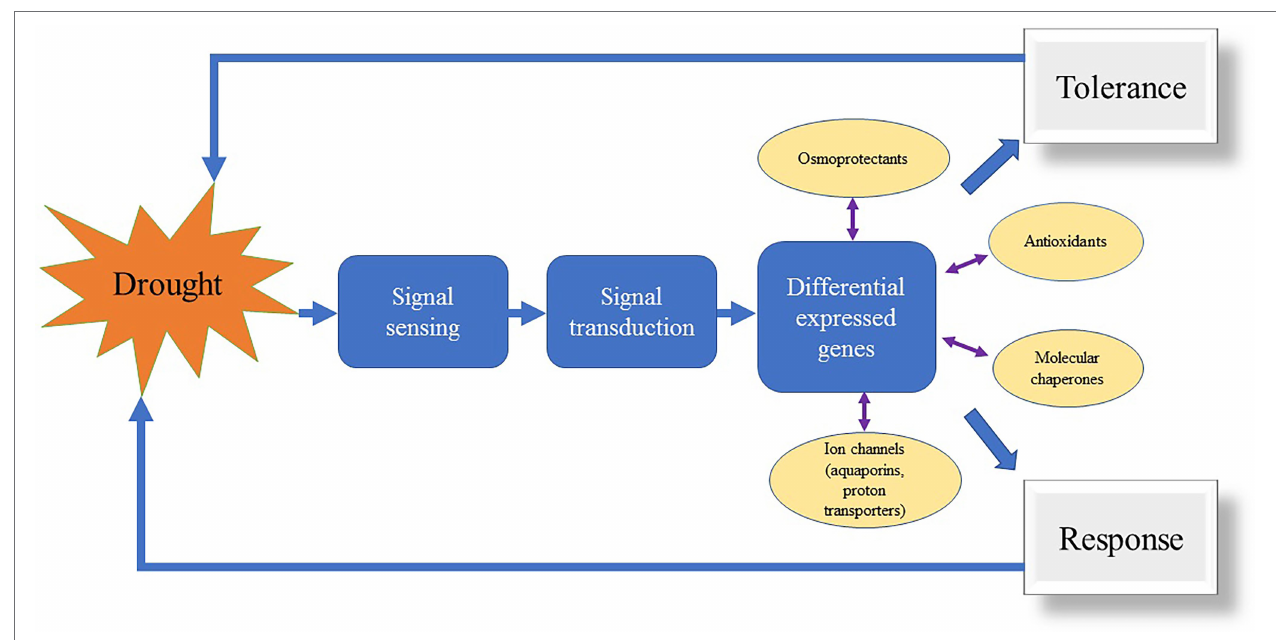
FIGURE 3 | Drought response mechanism in